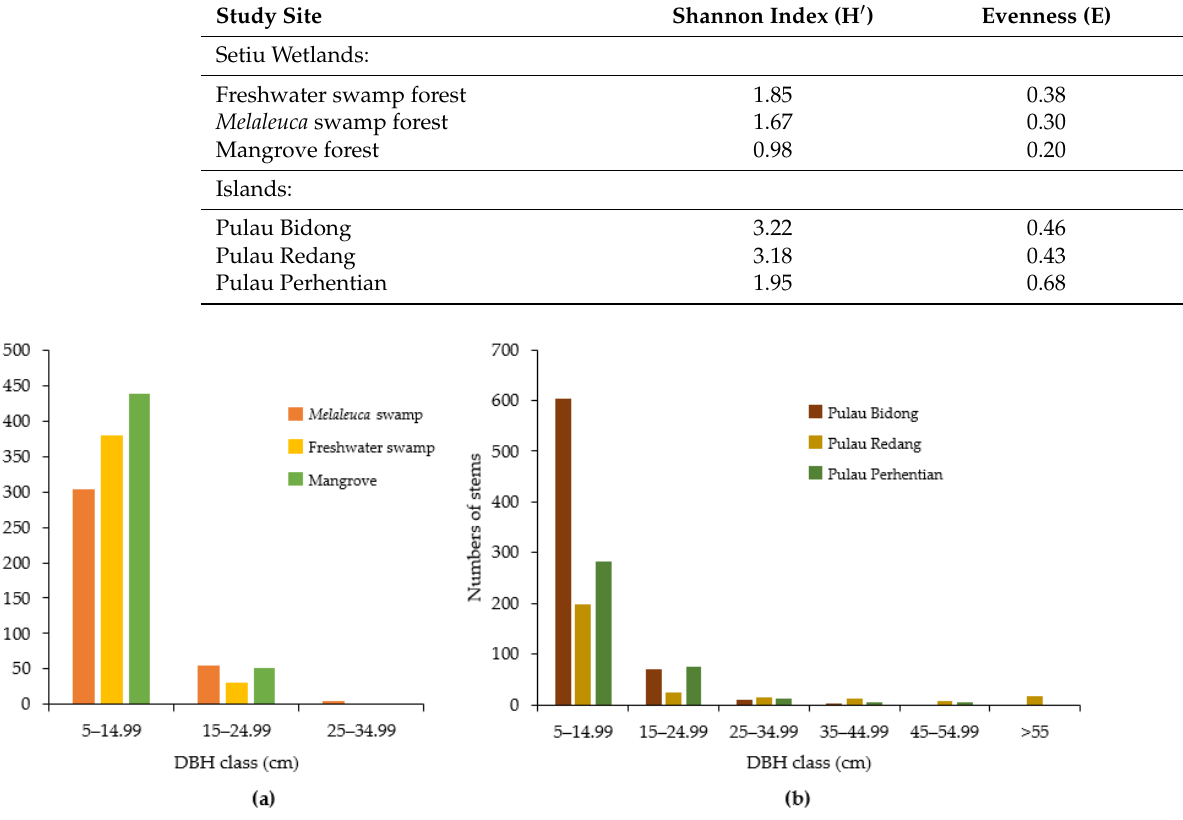
Figure 4. Diameter class distribution. ( a ) The Melaleuca swamp, freshwater swamp and mangrove forests in Setiu Wetlands; ( b ) the three major islands of Terengganu, Pulau Bidong, Pulau Redang, and Pulau Perhentian.